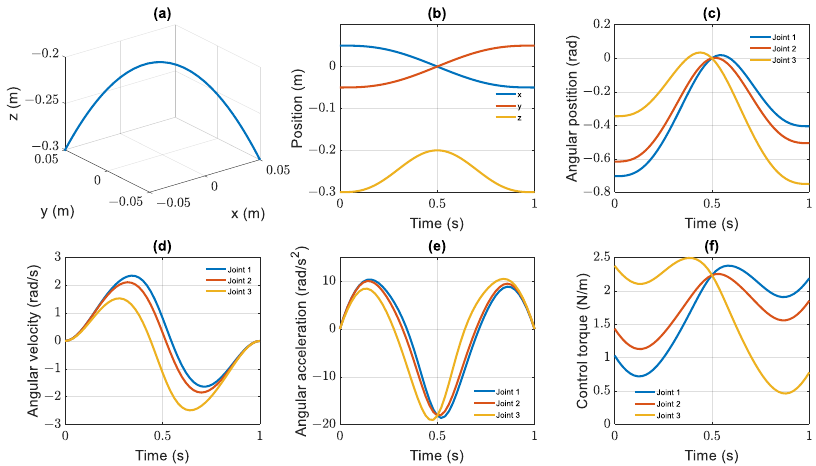
Figure 4. Parabolic characteristics: position transition in workspace ( a ), versus time ( b ); in joint space ( c ), angular velocities ( d ); angular accelerations ( e ); torques of delta manipulator ( f ).